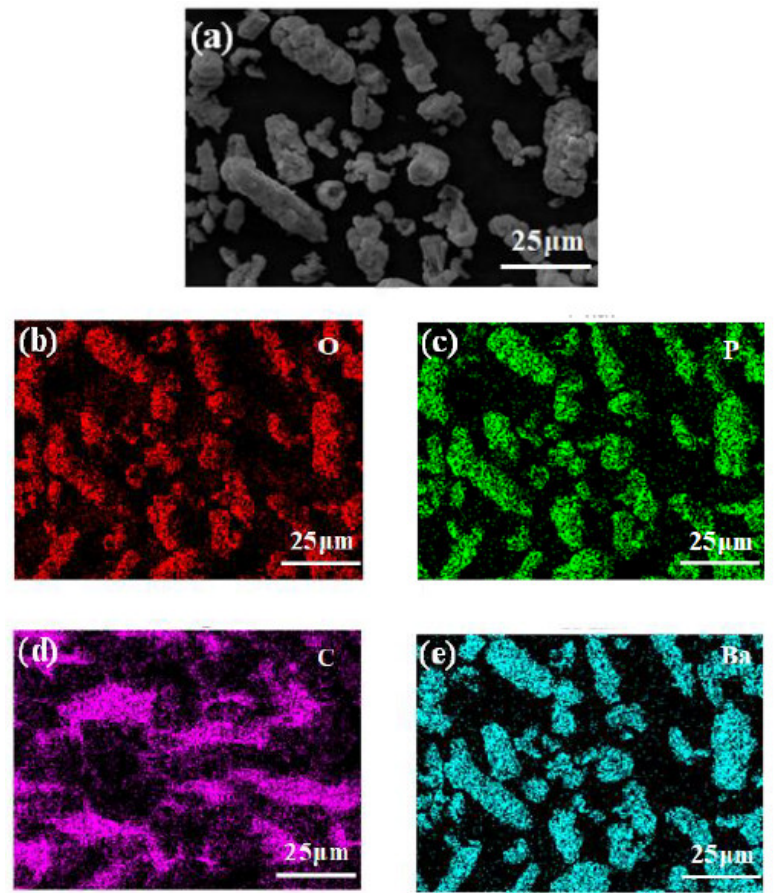
Figure 2. ( a ) SEM of Pa-Ba and ( b – e ) EDS spectrum of four main elements of Pa-Ba.